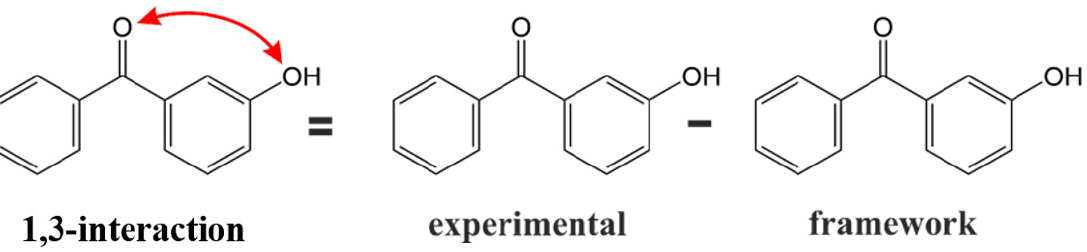
Table 9. Parameters and pairwise nearest and non ‐ nearest neighbour interactions of substituents on the “centrepieces” for calculation of thermodynamic properties of substituted benzenes and benzo ‐ phenones at 298.15 K (in kJ ∙ mol − 1 ).